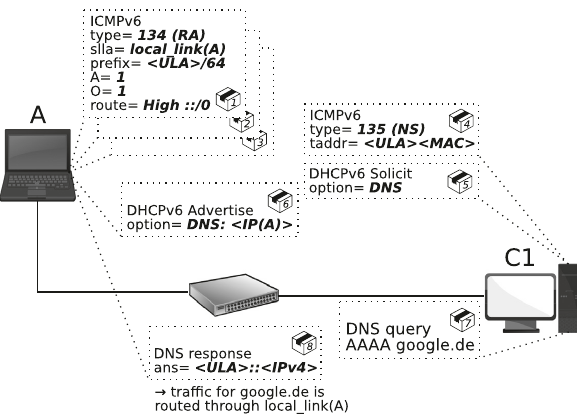
Figure 4: ICMPv6 router advertisement